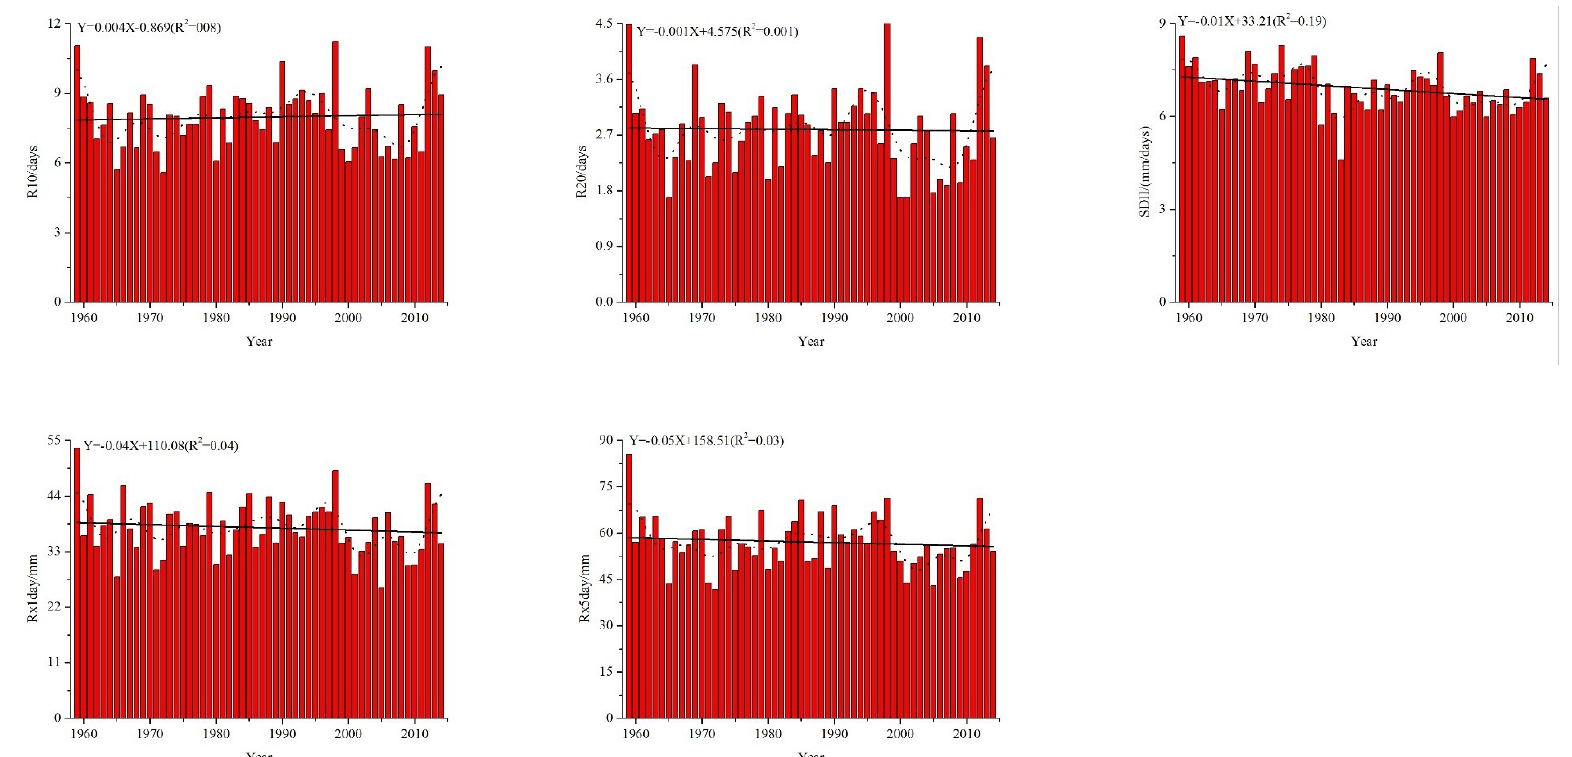
Figure 2. Averaged regional trends for precipitation indices during 1959–2014 in the IMP: The dot line and bold solid lines are time series smoothed by a low-pass filter and linear trend, respectively.